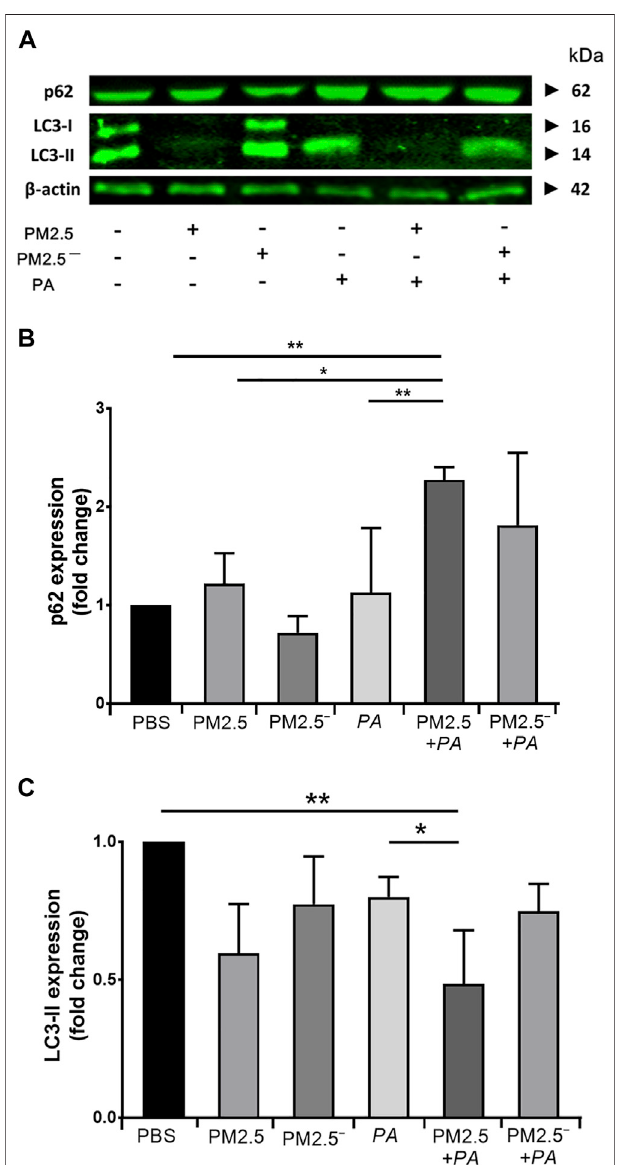
FIGURE 4 | Costimulation by PM2.5 and P. aeruginosa can promote autophagy. (A) Theexpressionlevelsofp62andLC3proteinsinthecellswere detected by Western blotting. (B,C) The expression levels of p62 and LC3 in the cells of each group. The experiment was repeated three times. PBS, phosphate-buffered saline; PM2.5, particulate matter less than 2.5 μ m in diameter; P . aeruginosa , Pseudomonas aeruginosa . The data are presented as the means ± SD. One-way ANOVA in SPSS. * p < 0.05, ** p < 0.01.